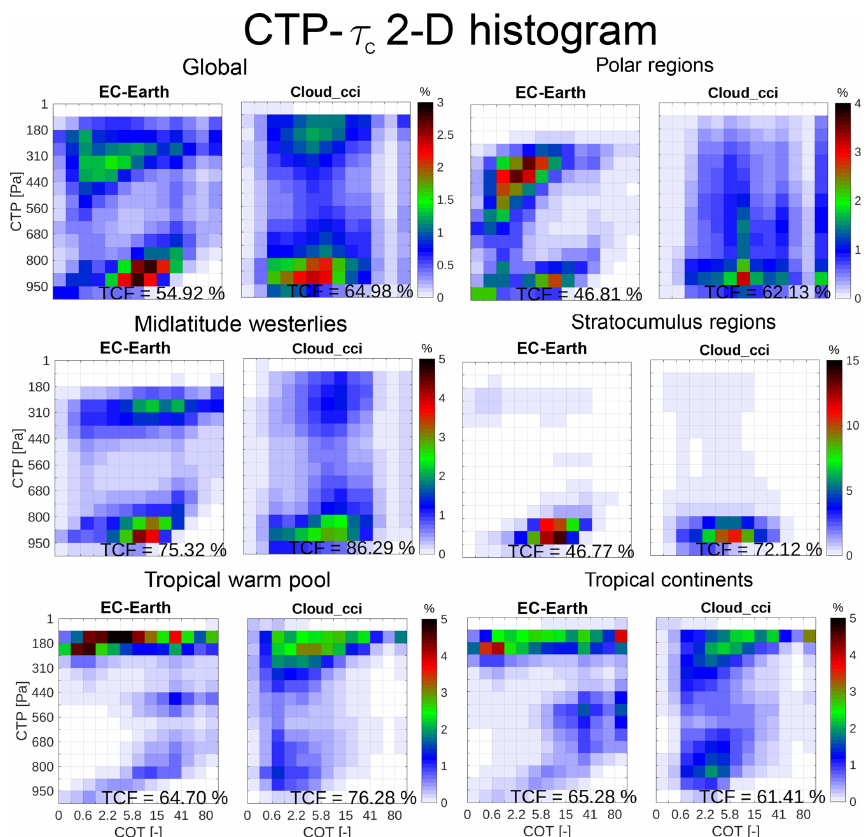
Figure 7. CTP– τ c histograms of simulated Cloud_cci based on EC-Earth (left column) and the Cloud_cci CDR (right column) for selected regions (see Fig. 6). Total cloud fractions for each region are indicated in the